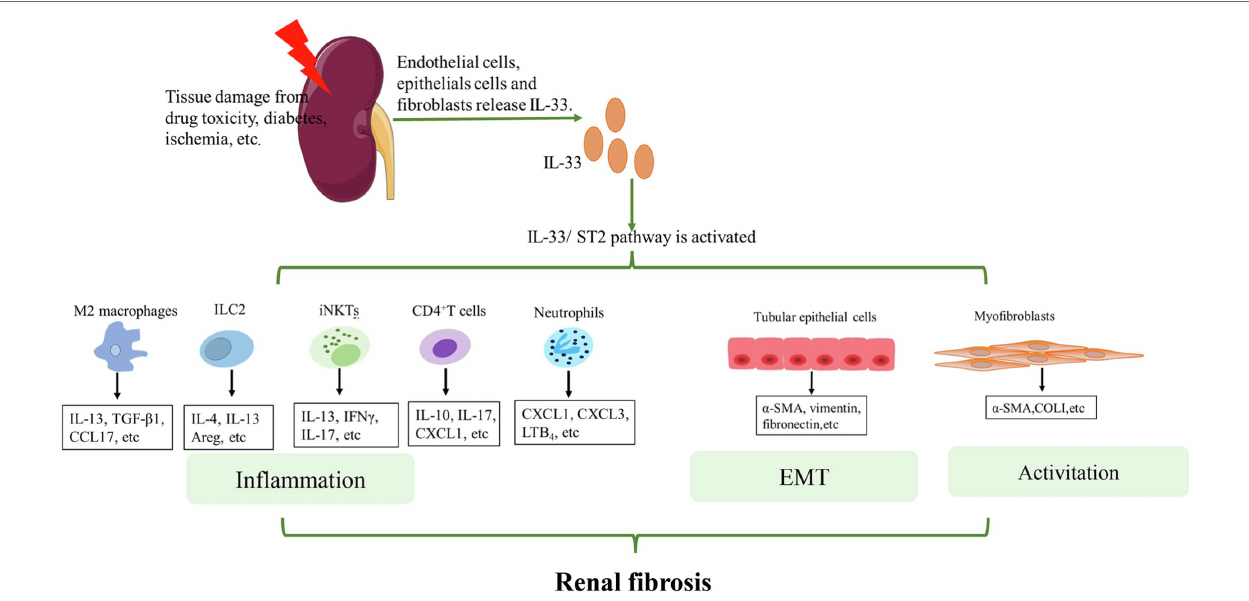
FIGURE 2 | Mechanisms of IL-33/ST2 involvement in renal fibrosis. When the kidney is injured, endothelial cells, epithelial cells, and fibroblasts release IL-33. IL-33 binds to ST2L on the cell membrane and activates downstream pathways. For immune cells, such as M2 macrophages, ILC2s, iNKTs, CD4 + T cells, and neutrophils, IL-33 activates these cells and promotes the secretion of some cytokines that further aggravate inflammation. For other non-immune cells in the kidney, IL-33 can lead to EMT of renal tubular epithelial cells and activation of myofibroblasts. Eventually, COL1, α -SMA etc. are produced. Continued inflammation, EMT, and activation of myofibroblasts finally lead to renal